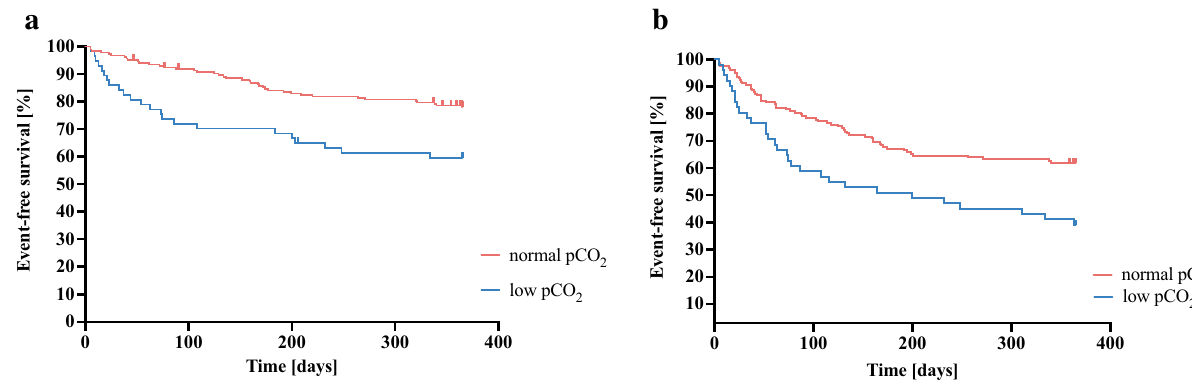
Figure 3. Kaplan–Maier curves for death or heart failure rehospitalization (whichever occurred first) by pCO 2 level on admission. ( a ) Death analysis. Log rank p = 0.002. Red line—patients with normal pCO 2 value (> 30 mmHg). Blue line—patients with low pCO 2 value (≤ 30 mmHg). ( b ) Death or heart failure rehospitalization (whichever occurred first) by pCO 2 level on admission. Log-rank p = 0.002. Red line—patients with normal